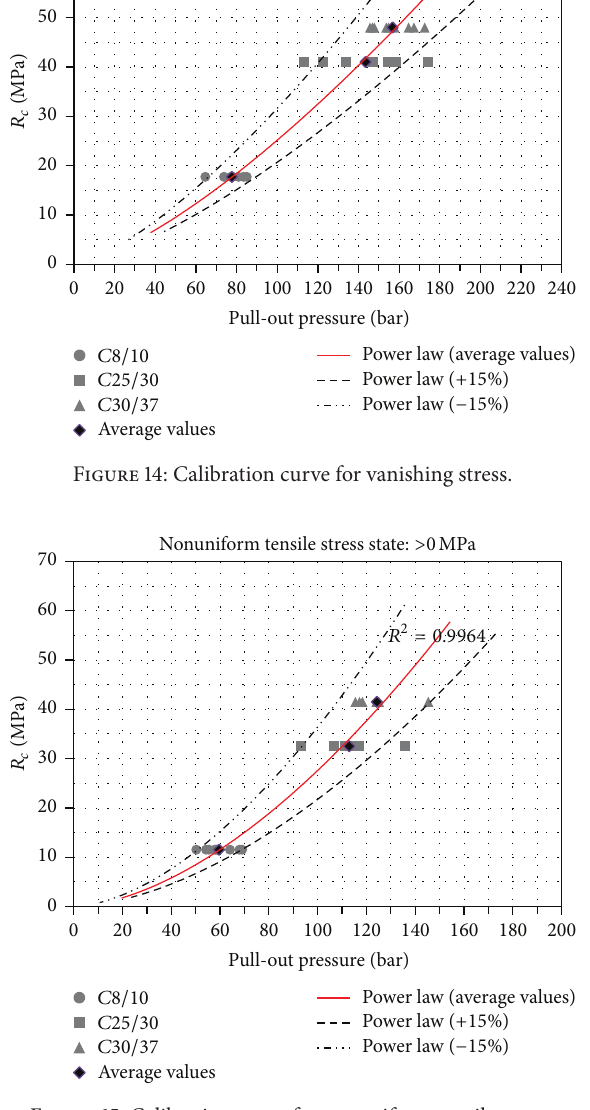
Figure 15: Calibration curve for nonuniform tensile